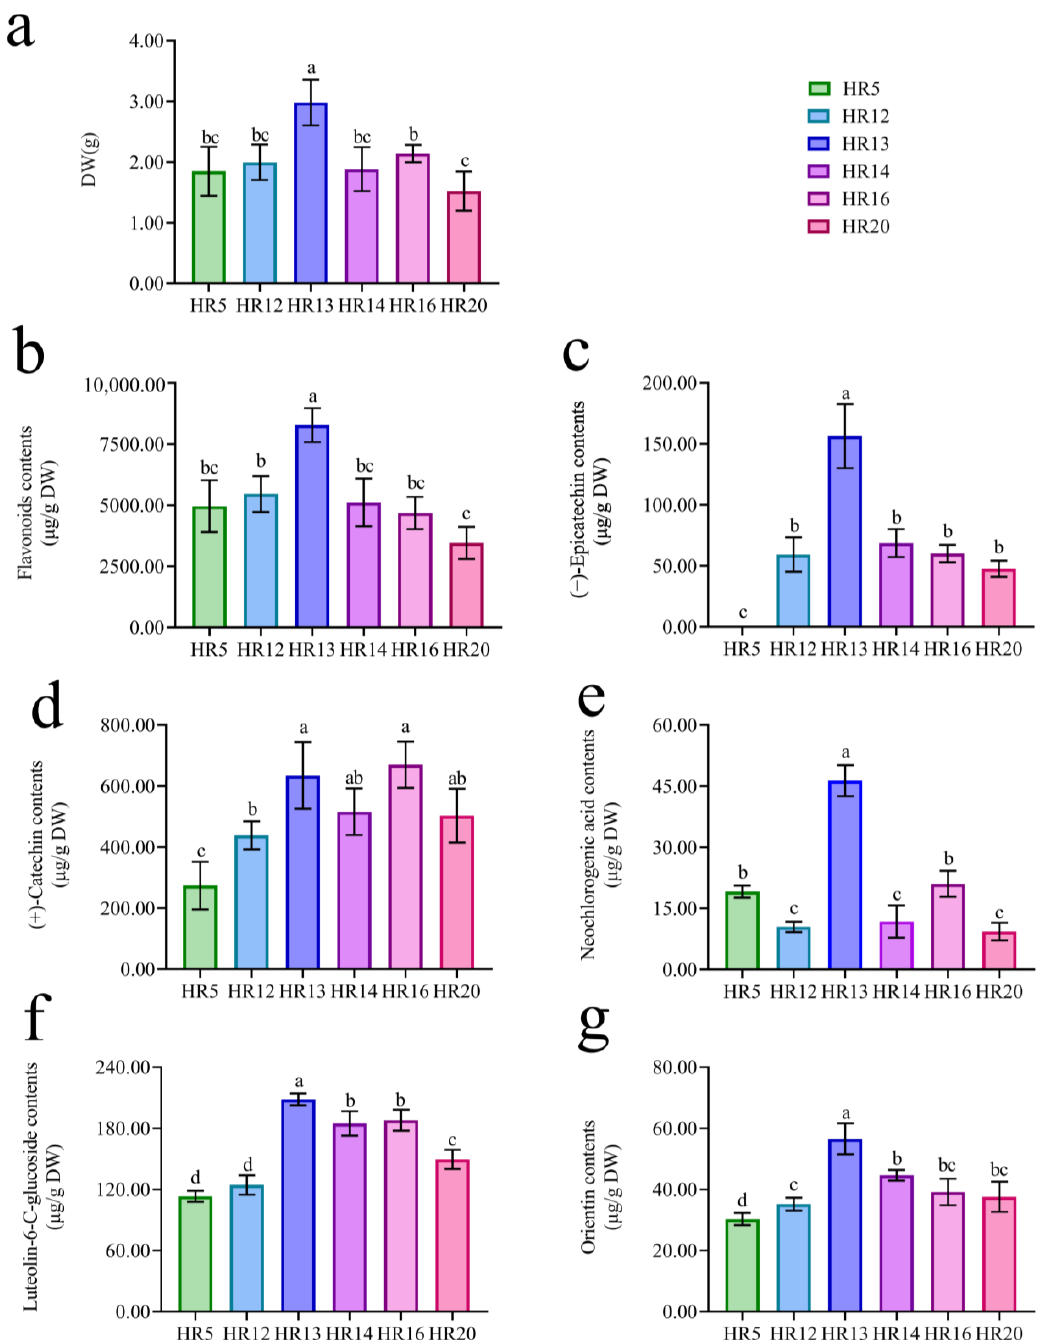
Figure 4. Evaluation of biomass productivity and flavonoids yield of T. hemsleyanum hairy roots lines. ( a ) Dry weight comparison of hairy roots lines. ( b ) Total flavonoids contents of hairy roots lines. ( c ) ( − )-Epicatechin contents of hairy roots lines. ( d ) (+)-Catechin contents of hairy roots lines. ( e ) Neochlorogenic acid contents of hairy roots lines. ( f ) Luteolin-6-C-glucoside contents of hairy roots lines. ( g ) Orientin contents of hairy roots lines. All the experiments were performed in triplicate with at least three independent runs ( n = 9). Significant differences are represented by different letters (a–d) ( p <